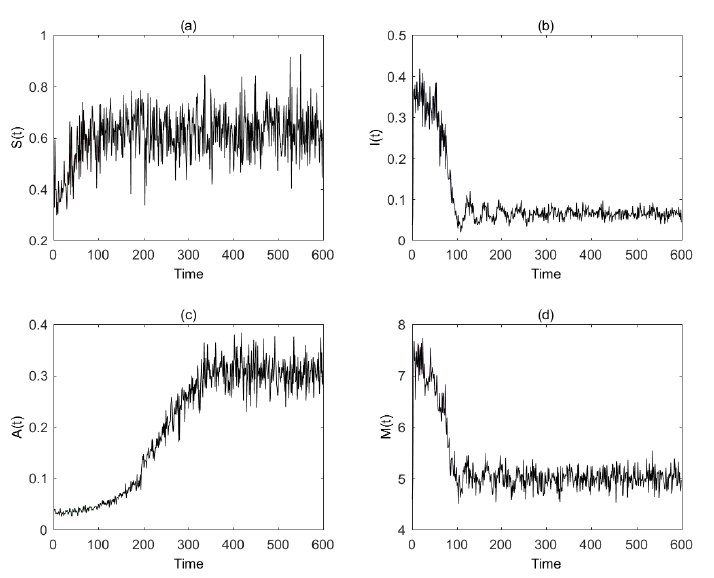
√ Figure 2. If σ i 1 ( n ) = 0.04 + 0.01sin n , σ i 2 ( n ) = 0.1 + 0.05sin n ( i = 1,2,3,4 ) , c 1 ( u ) = 0.4, c 2 ( u ) = 0.03, c 3 ( u ) = 0.02, c 4 ( u ) = 0.05, ϑ = 0.5, then it is easy to show that (cid:101) R 1 = 0.0426, (cid:101) R 2 = − 0.0849, (cid:101) R 3 = 0.0551, (cid:101) R 4 = − 0.0415, which follows that (cid:101) R s = 0.0176 > 0. The dynamical responses S ( t ) , I ( t ) , A ( t ) , M ( t ) of system (4) with initial value ( 0.35,0.15,0.04,5 ) are plotted in ( a – d ), respectively, which indicates an exponential